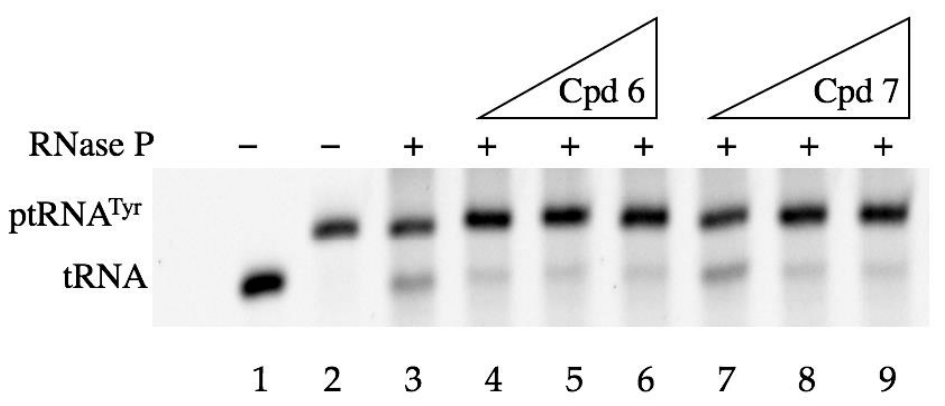
Figure 5. In-vitro ptRNA maturation assay for Compounds 6 and 7 . 0, 62.5, 250, or 500 µ M compound was incubated with 10 pmol RNase P and ptRNA Tyr for 30 min at 37 ◦ C and conversion of ptRNA to tRNA was evaluated by urea-PAGE; migration of tRNA Tyr and ptRNA Tyr are shown.